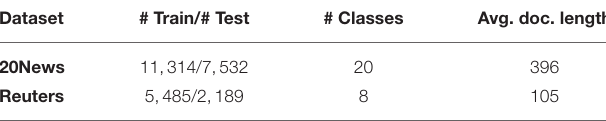
TABLE 2 | Dataset statistics.